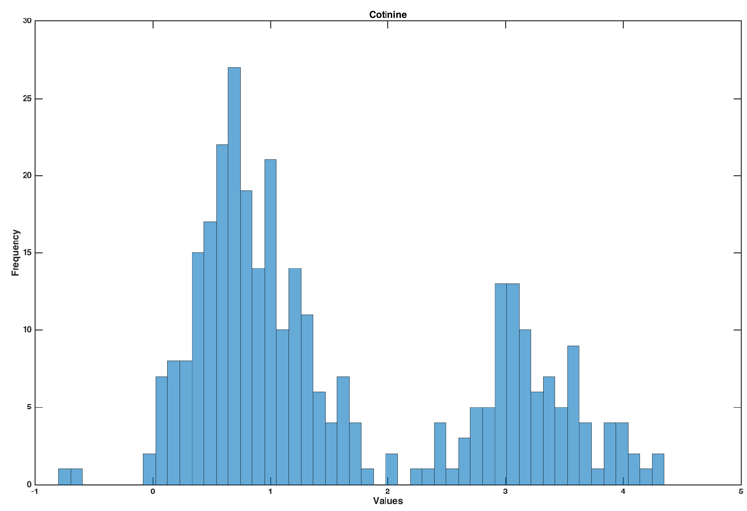
Figure 1. Distribution of log 10 -concentration values of urinary cotinine in 322 subjects.